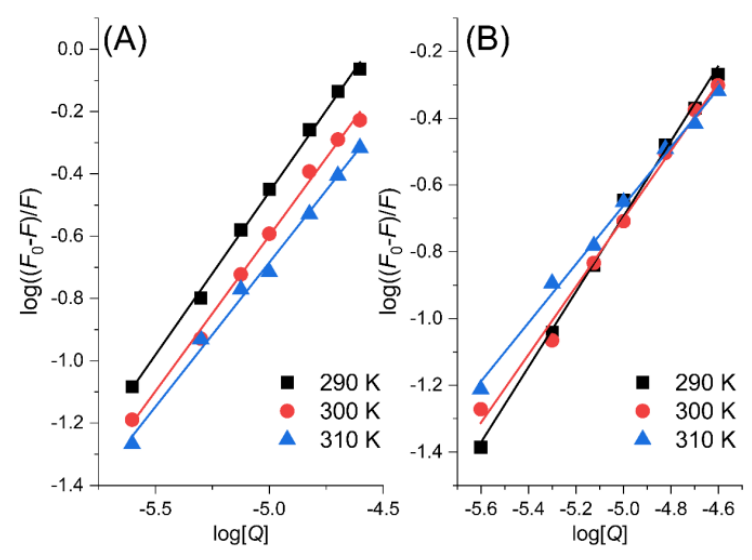
Figure 4. Double − logarithmic plots of PK − MYR ( A ) and PK − MYT ( B ). Based on the binding constants K A at different temperatures, namely 290, 300, and 310 K, respectively, listed in Table 1, the interaction forces between PK and MYR/MYT by the Van’t Hoff equation [22,23], Equations (4) and (5), could be elucidated.